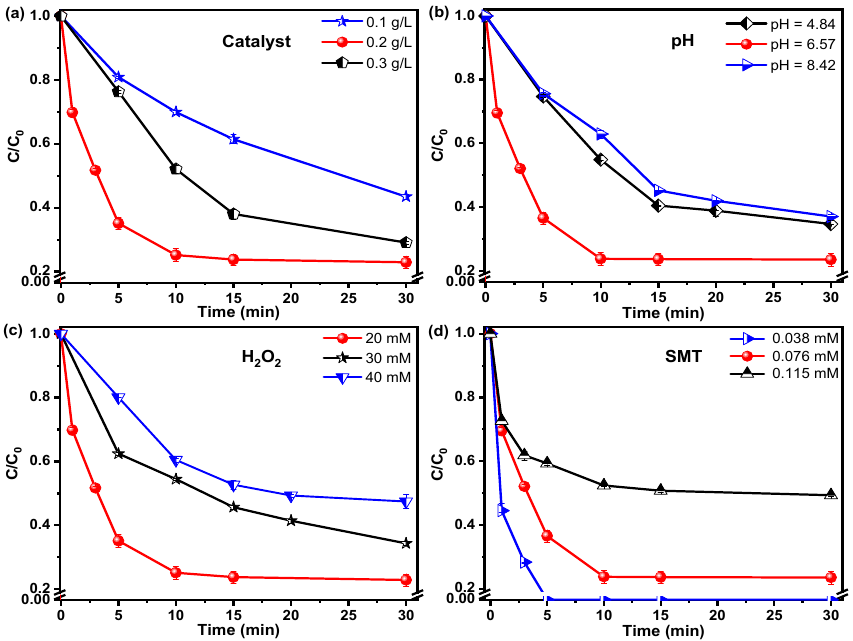
Figure 5. Effect of the operating conditions on the SMT removal over the Fe-Mo/rGO catalyst. (( a ) Catalyst dosage: [SMT] 0 = 0.076 mM, [H 2 O 2 ] 0 = 20 mM, pH = 6.57, T = 25 °C; ( b ) pH value: [SMT] 0 = 0.076 mM, [Catalyst] = 0.2 g/L, [H 2 O 2 ] 0 = 20 mM, T = 25 °C; ( c ) H 2 O 2 concentration: [SMT] 0 = 0.076 mM, [Catalyst] = 0.2 g/L, pH = 6.57, T = 25 °C; ( d ) SMT concentration: [Catalyst] = 0.2 g/L, [H 2 O 2 ] 0 = 20 mM, pH = 6.57, T = 25 °C).